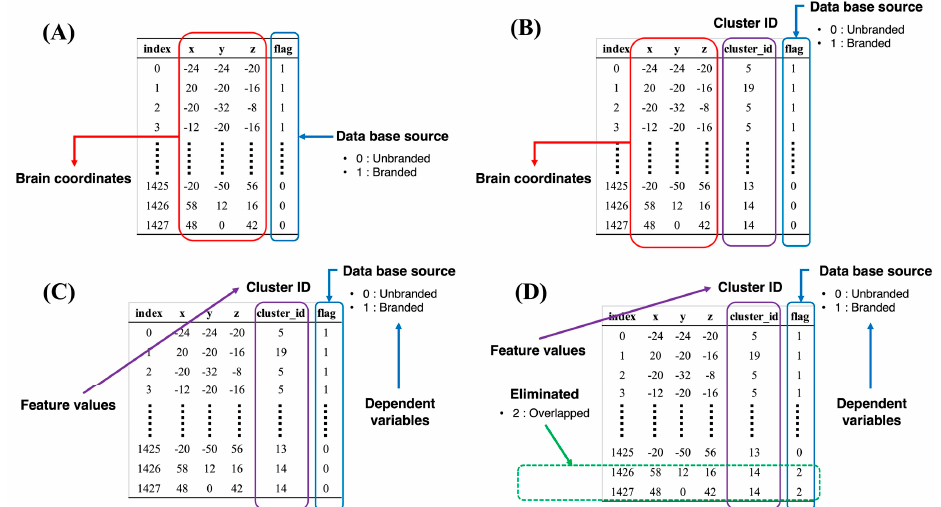
Figure 2. All foci plotted on the Colin27 template. Top left = coronal view; Top right = sagittal view; Lower right = axial view.